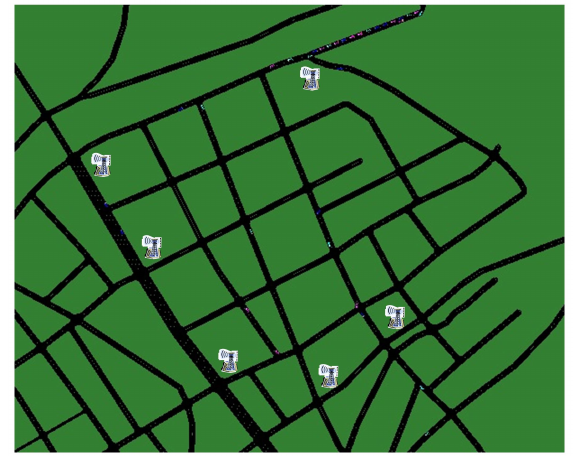
Figure 1. City is divided in subnetworks. RSUs are located at the entrances/exits of each